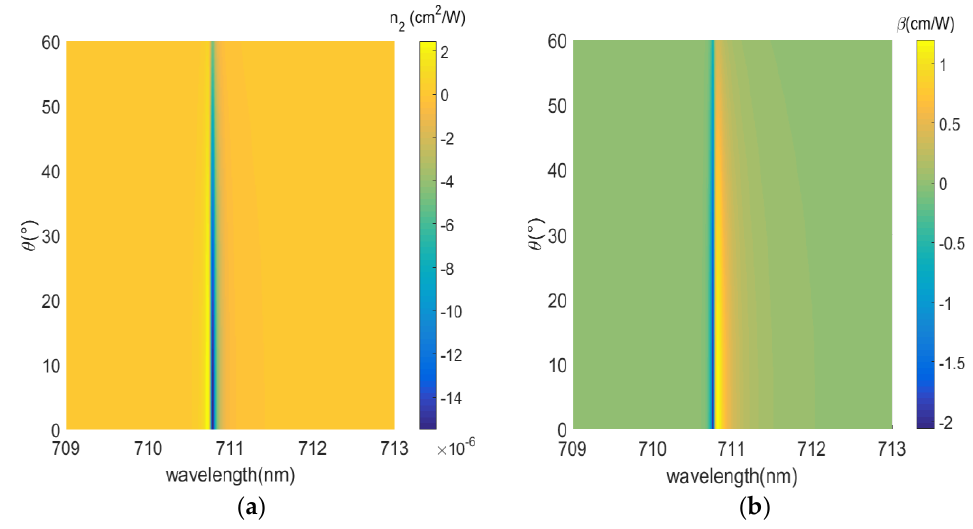
Figure 13. Nonlinear coefficient as a function of incident angle and gain medium concentration (3.3 mM). ( a ) Nonlinear refraction index n 2 . ( b ) Nonlinear absorption coefficient β Table 2. Comparisons of the third-order nonlinear optical coefficients of different doping concen- trations.